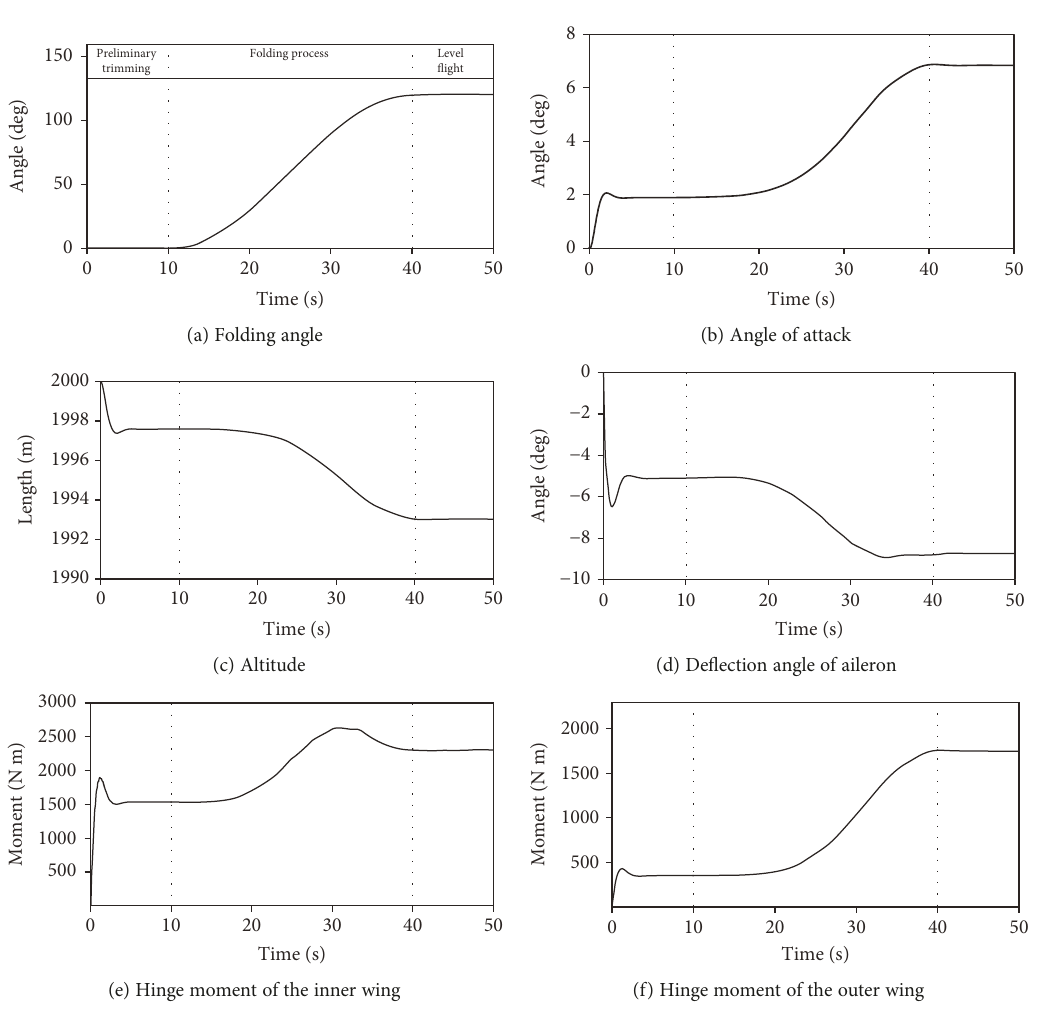
Figure 7: Dynamic response during the fl ight-folding process. Table 2: Comparison of statically trimmed